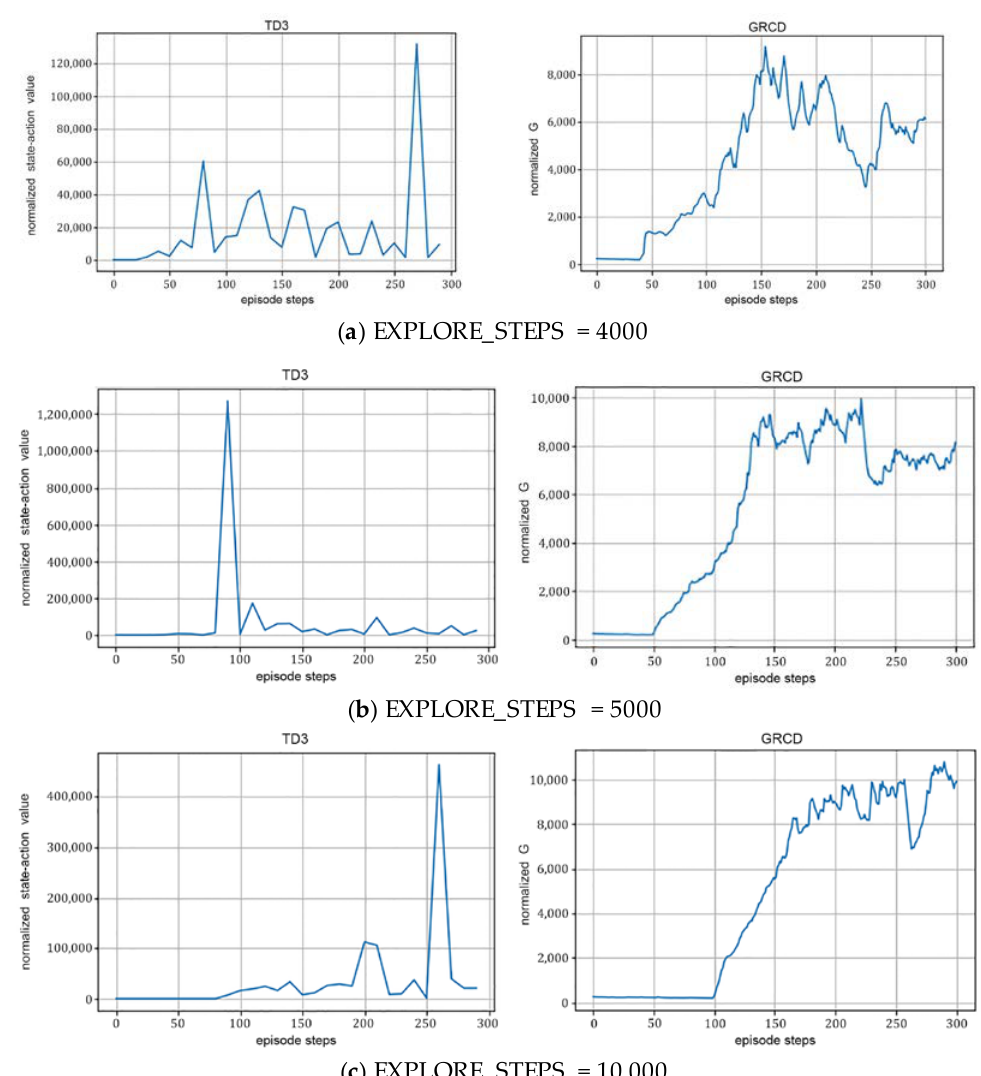
Figure 6. Effect of different exploration step lengths on the performance of the algorithm with N = 36, 0.99 γ= and Hidden_dim = 128.